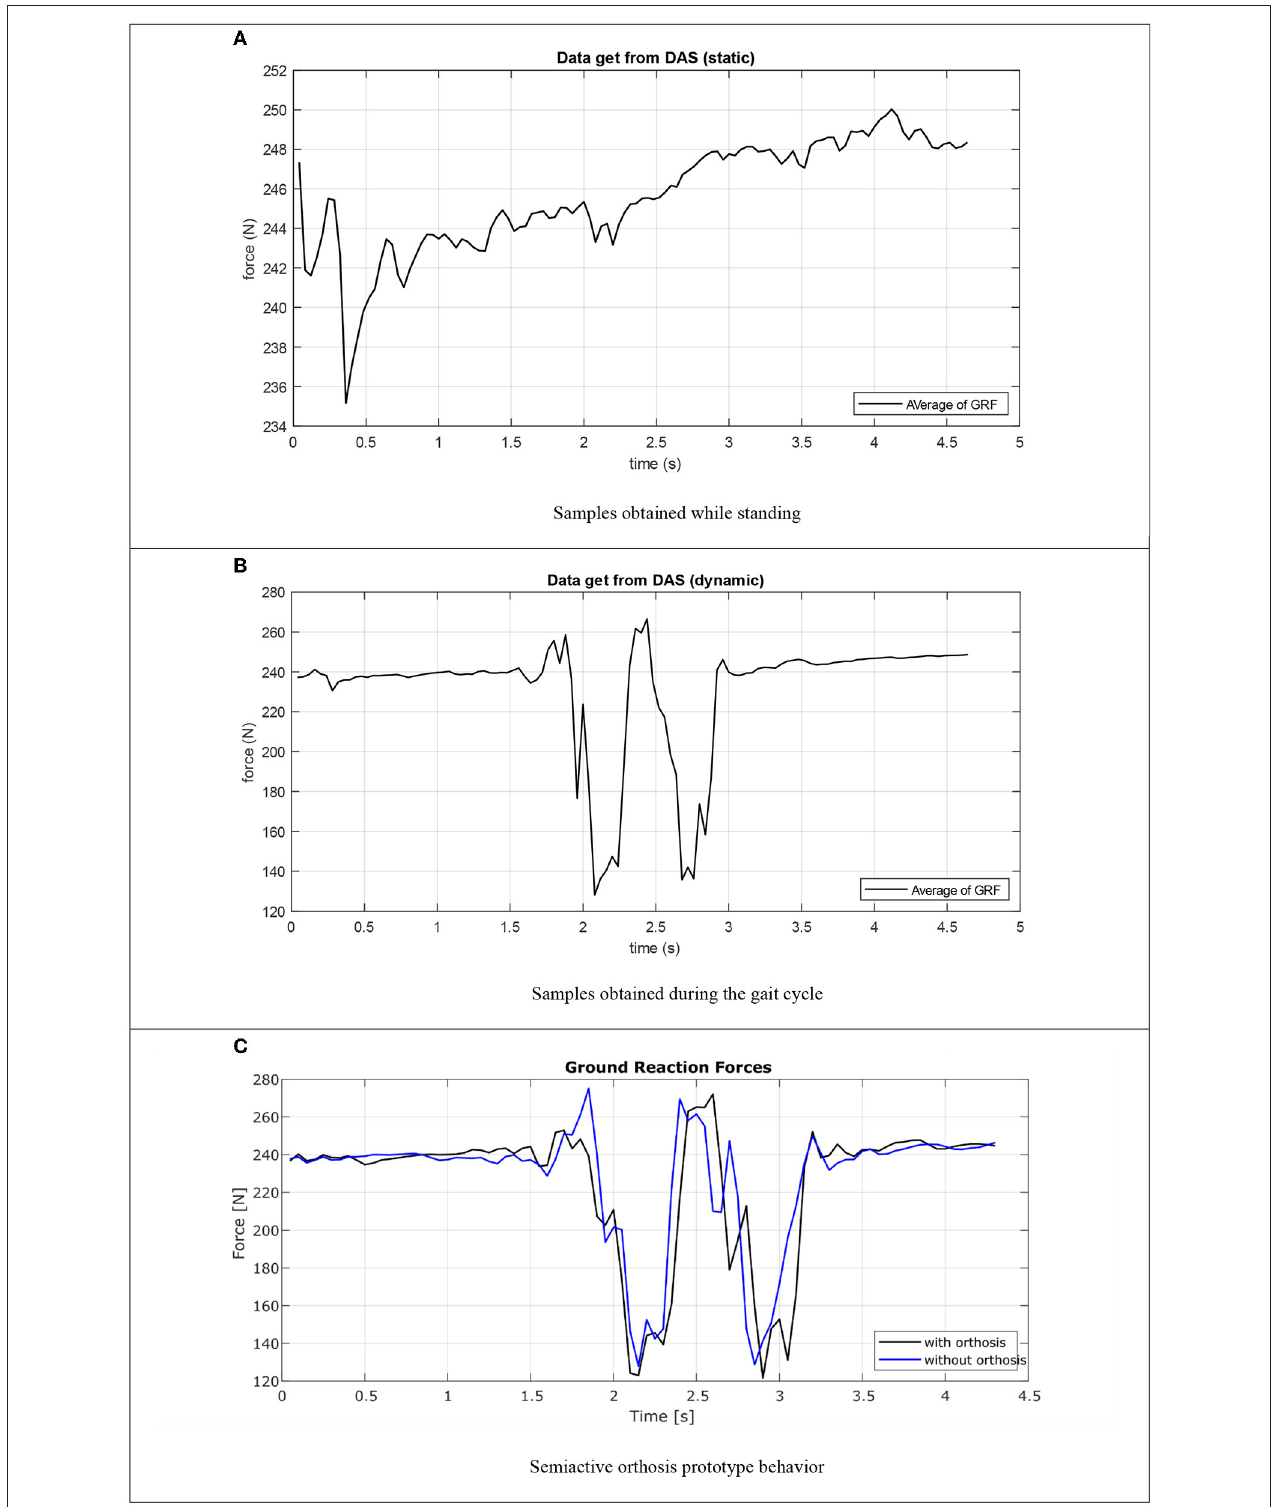
FIGURE 15 | Semi-active orthosis evaluation. (A) Samples obtained while standing. (B) Samples obtained during the gait cycle. (C) Semiactive orthosis prototype behavior.